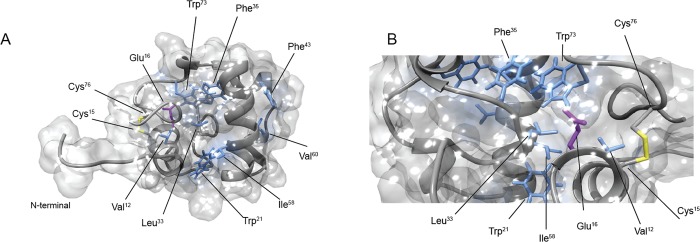
The hydrophobic pocket.(A,B) Close-up views of the hydrophobic pocket close to the catalytic glutamate (Glu16). The catalytic glutamate is depicted in magenta, the disulfide bond (Cys15-Cys76) in yellow and all other residues in light blue.